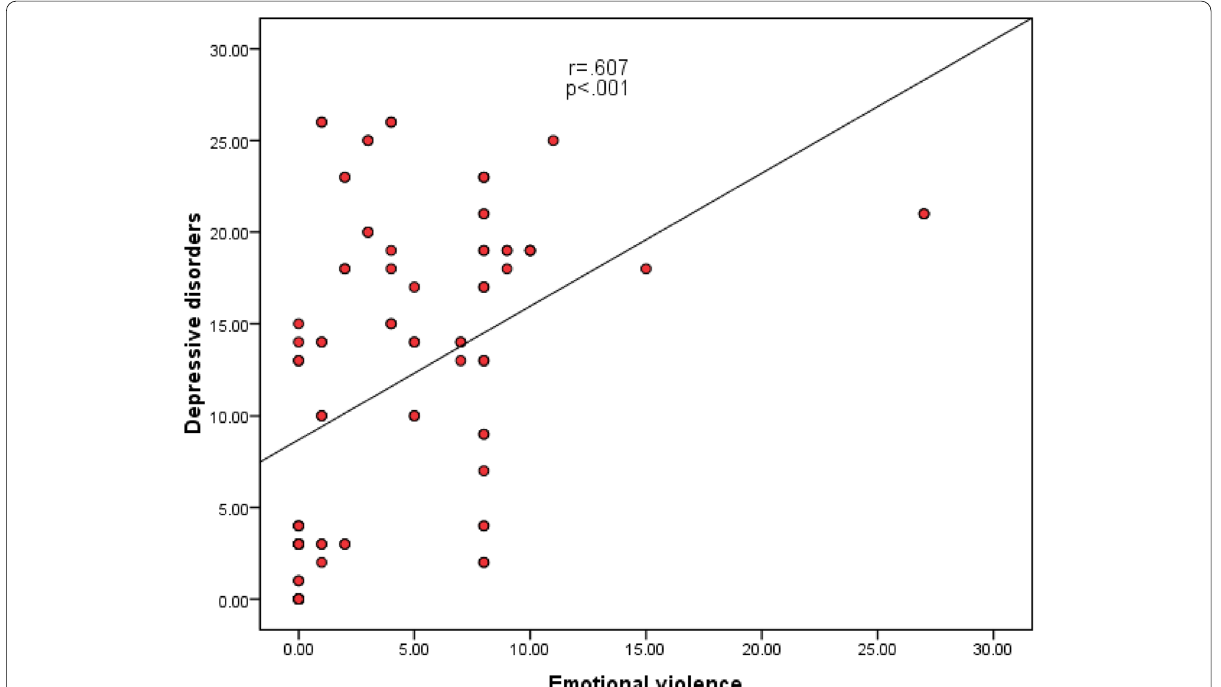
Fig. 7 Scatter diagram showing correlation between emotional violence and depressive disorder